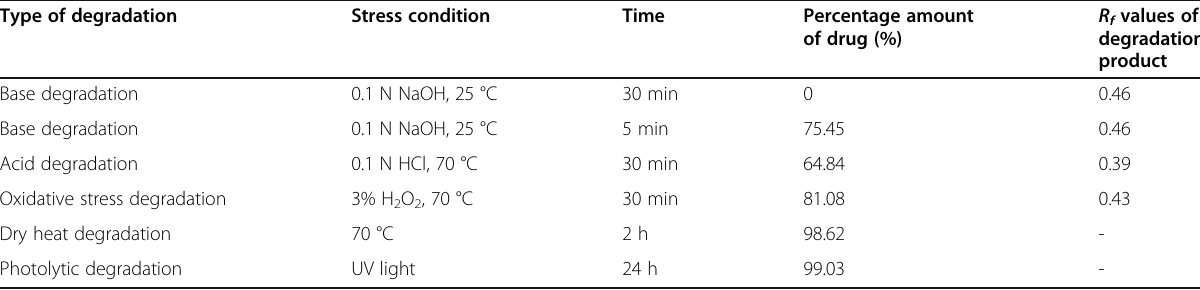
Table 5 Analysis of tablet dosage form Amount of drug applied (ng/band) a